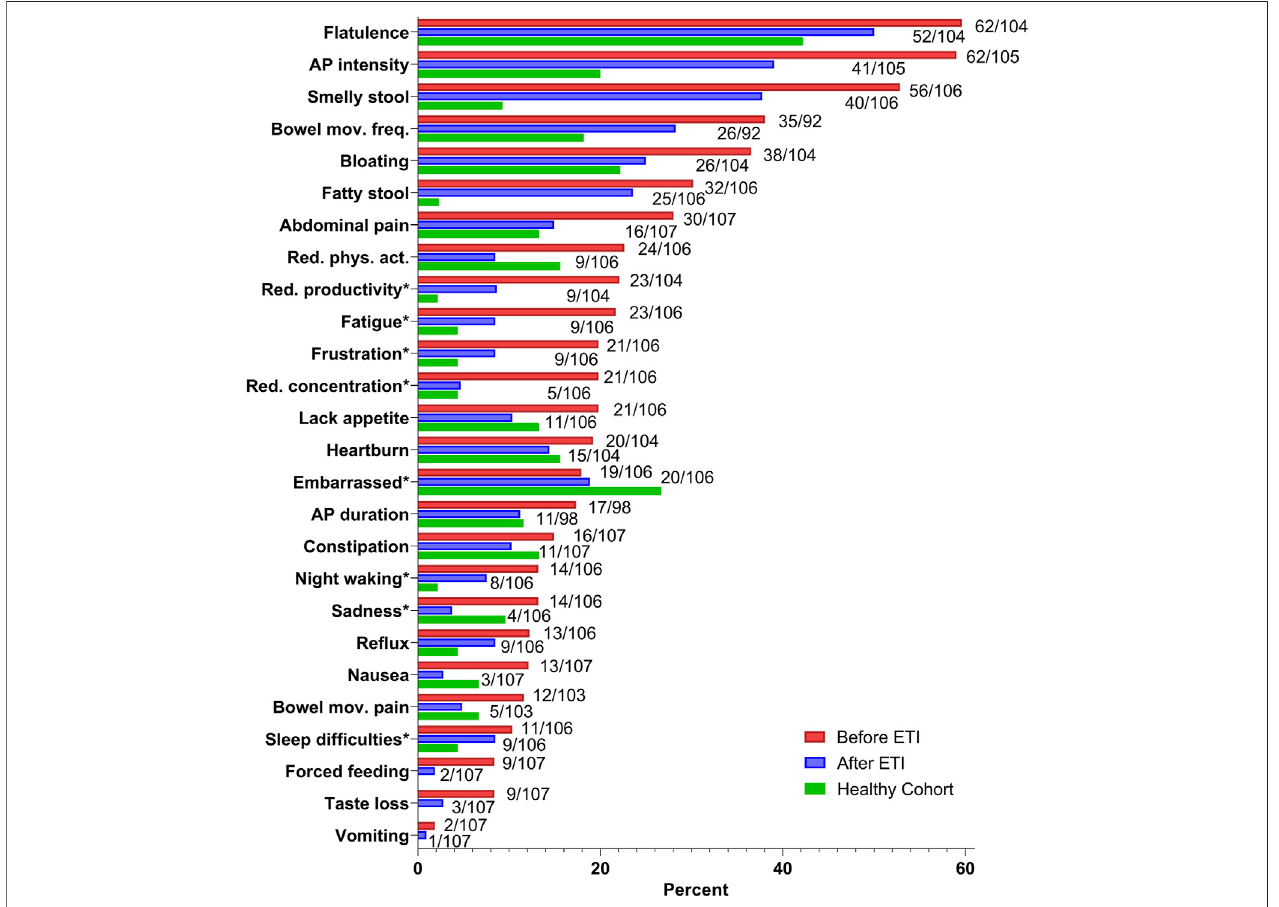
FIGURE2| ChangesinresponsesforsingleitemsincludedintheCFAbd-Scorefrom107pwCFduringtreatmentwithElexacaftor-Tezacaftor-Ivacaftor,compared to responses obtained from a cohort of 45 German healthy controls without food allergy or intolerance. Percentages of patients reporting each symptom at least occasionally (2 – 3 times during the past 2 weeks) are listed. Items displaying a total number of pwCF less than 107 indicate that a fraction of participants left some questionsunanswered.Thepercentageoftotalunansweredquestionsoverthewholestudywas1.5%.Fromatotalof28itemsincludedintheCFAbd-Score,stool colour and stool consistency, as parts of the modi fi ed Bristol stool scale, were excluded. For frequency of bowel movement, changes regard those reporting at least 2 – 3 stools/day. *Items regarding quality of life were assessed as relating to abdominal symptoms. AP: abdominal pain; Bowel mov. freq.: bowel movement frequency; Red. phys.act.: Reduced physical